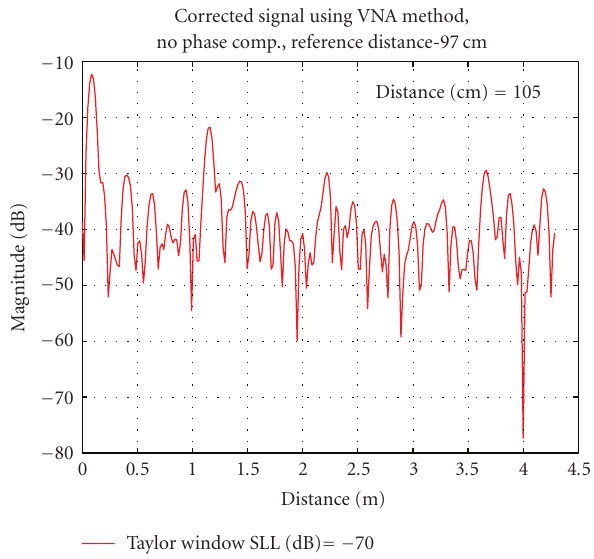
Figure 5: Calibrated A -scan using VNA method; reference distance-97 cm, separation 105 cm.